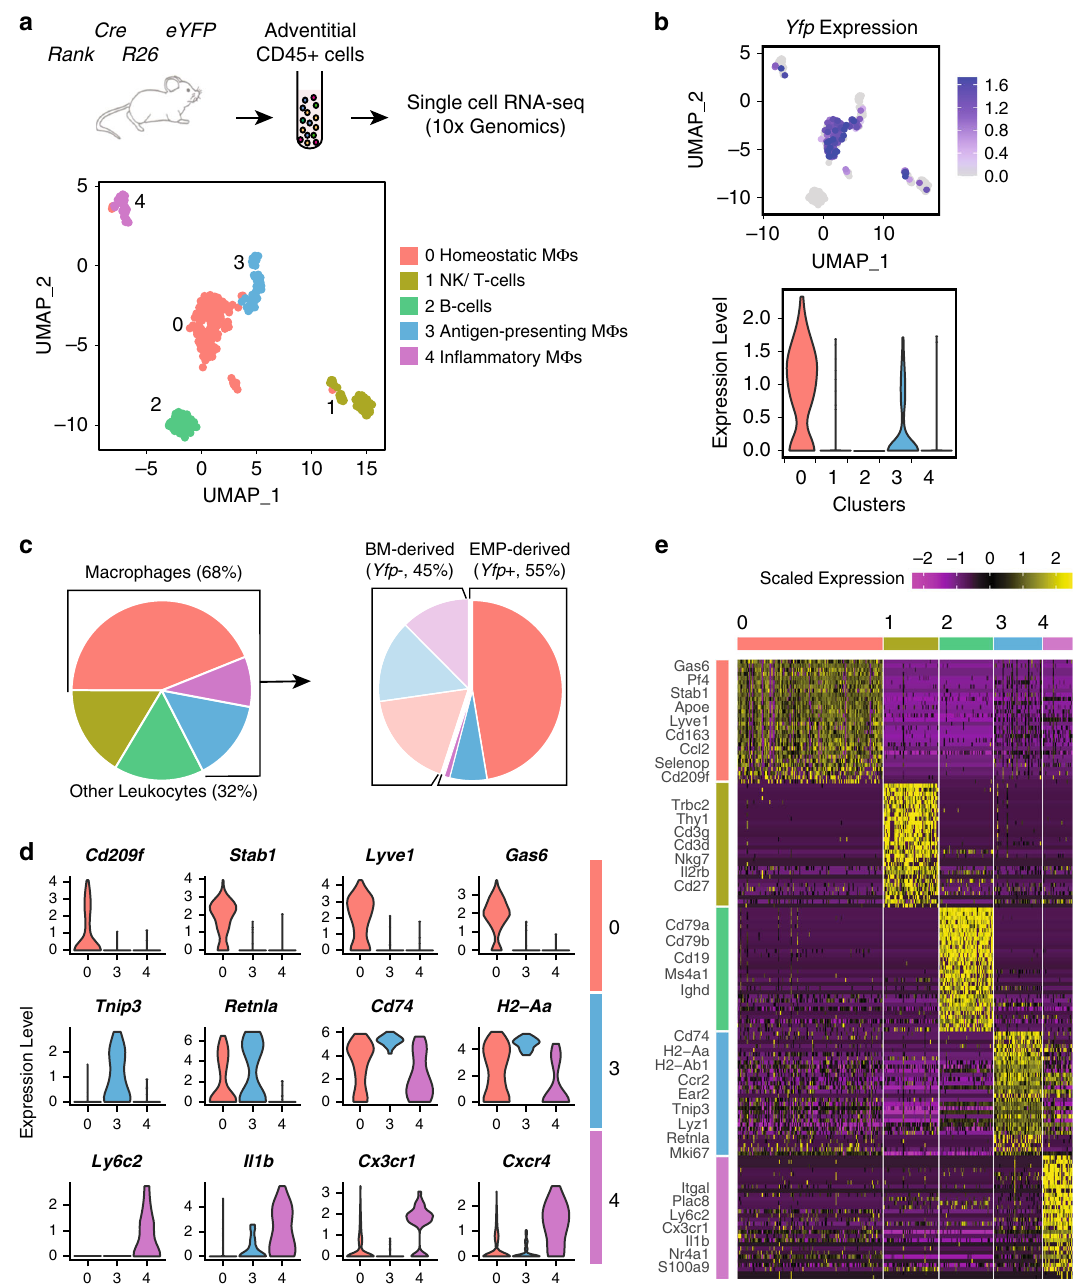
Fig. 2 Transcriptional pro fi ling of EMP-derived macrophages. Single-cell RNA sequencing of CD45 + immune cell populations in the adventitia at steady state. a Experimental design and UMAP representation of gene expression in single CD45 + cells collected from aortas of Rank Cre Rosa26 eYFP mice ( n = 346 cells from three 16-week-old mice). Cells clustered into fi ve distinct populations, namely different macrophage subtypes, B and T lymphocytes and NK cells. b Expression of Yfp in adventitial leukocytes depicted as Feature (upper panel) and Violin (lower panel) plots. Expression of transgene is mainly identi fi ed in homeostatic macrophages (cluster 0). c Pie charts depicting the proportion of various leukocyte populations in adventitia (left panel) and fraction of Yfp - expressing cells within adventitial macrophages (right panel). Macrophages comprise the majority of adventitial leukocytes at steady-state (68% of total). d Violin plots representing expression of speci fi c markers of homeostatic (cluster 0), antigen-presenting (cluster 3), and in fl ammatory (cluster 4) macrophages. e Heatmap showing top30 enriched genes in each leukocyte cluster. Expression scale is Log2 fold-change of gene expression in the corresponding cluster compared to all other clusters. Established markers of each cell type are